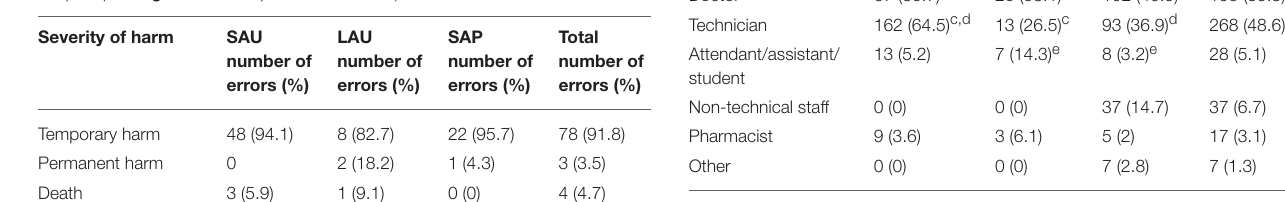
Other refers primarily to administration, management and client service staff. Like superscripts indicate significant